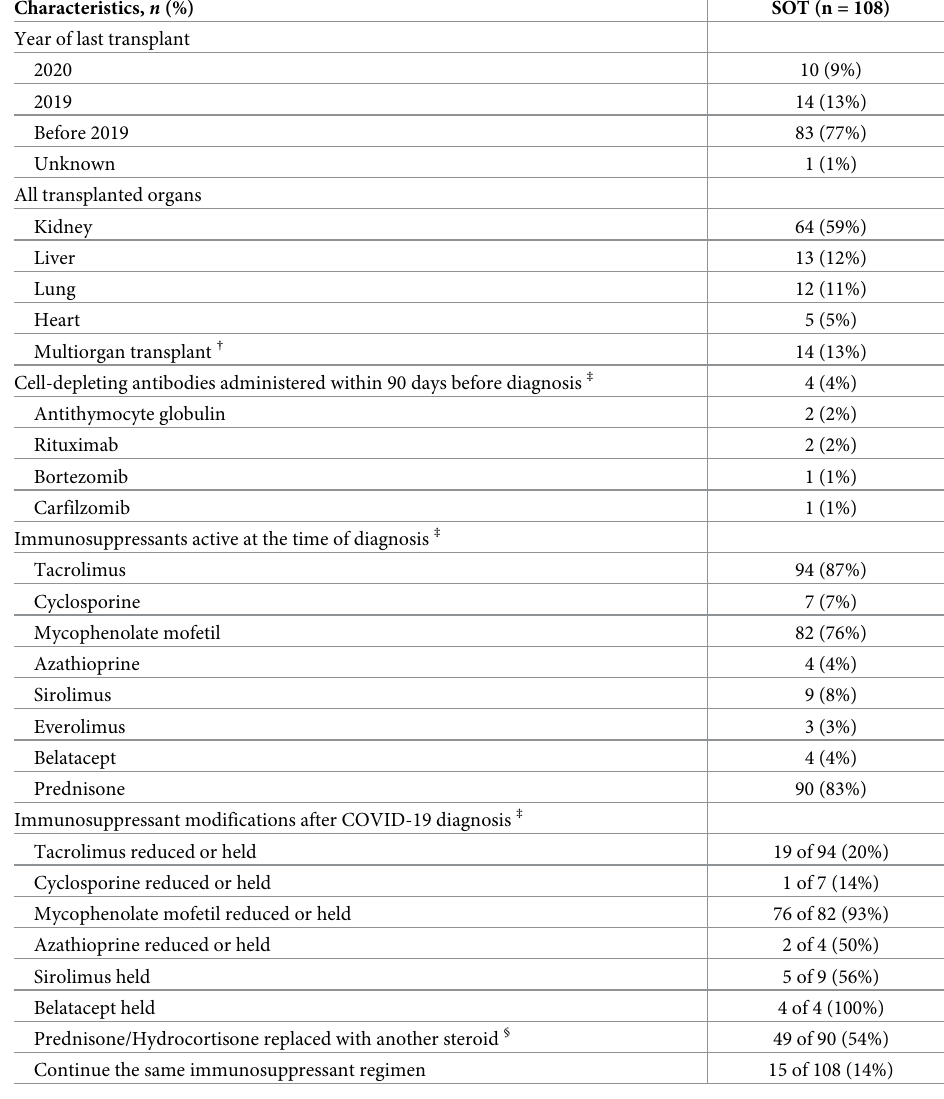
Table 1. Characteristics and immunosuppression therapy for SOT recipients. Characteristics, n (%)